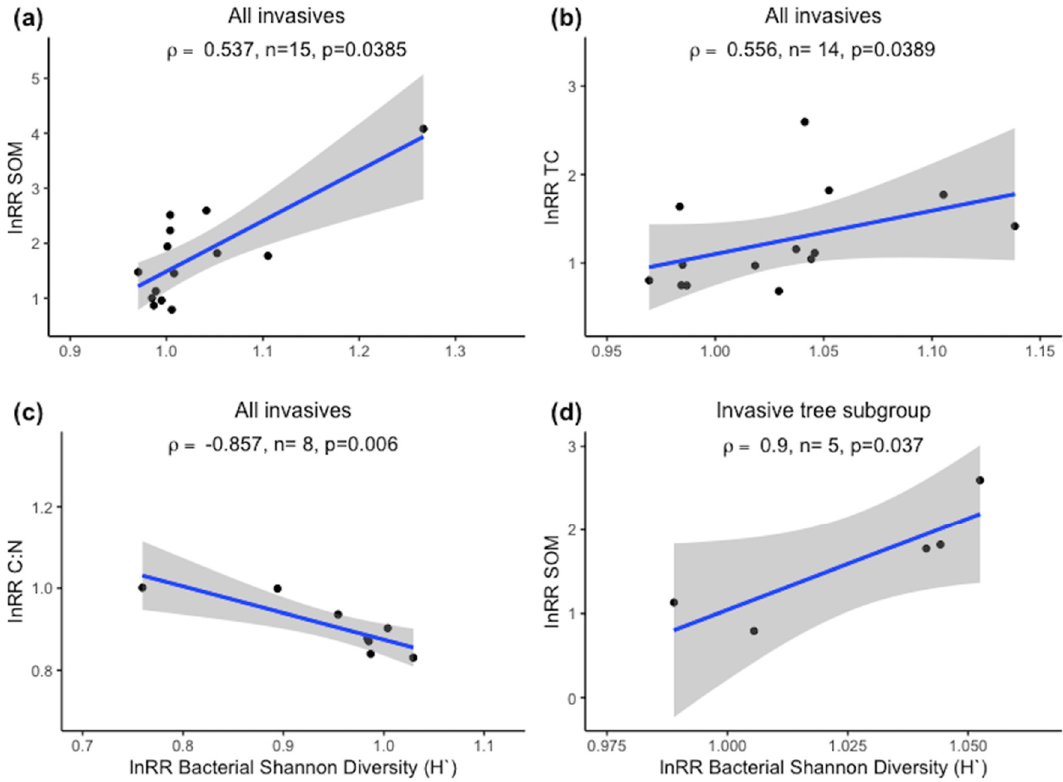
Figure 4. Scatter plots of invasion-induced changes in α -diversity by changes in nutrient status metrics. Only significant Spearman correlations ( p < 0.05 and n ≥ 5) are shown. Grey bands represent the 95% CI of the fit regression line. All panels follow the same formatting. ( a ) Bacterial Shannon diversity (H‘) by soil organic matter (SOM); ( b ) Bacterial Shannon diversity (H‘) by total carbon (TC); ( c ) Bacterial Shannon diversity (H‘) by C:N; and ( d ) Bacterial Shannon diversity (H‘) of the invasive tree / shrub subgroup by SOM.